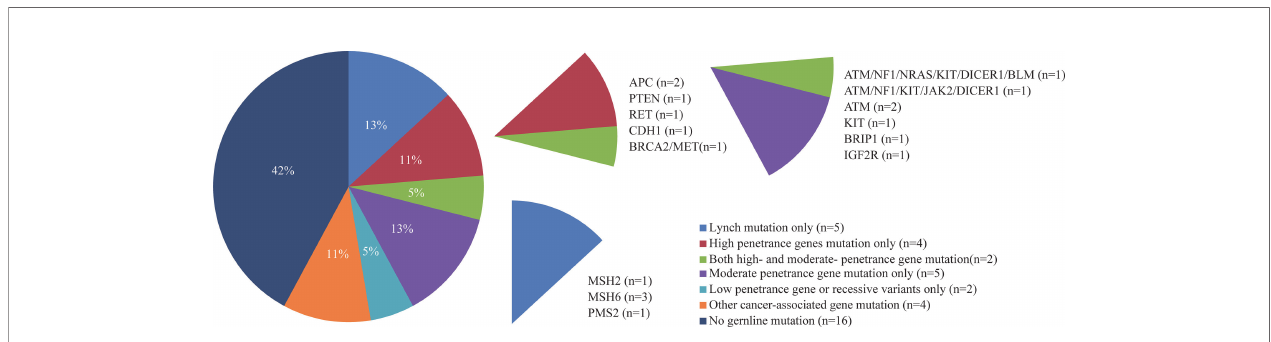
FIGURE 2 | Frequency and penetrance of germline pathogenic/likely pathogenic variants in patients with suspected